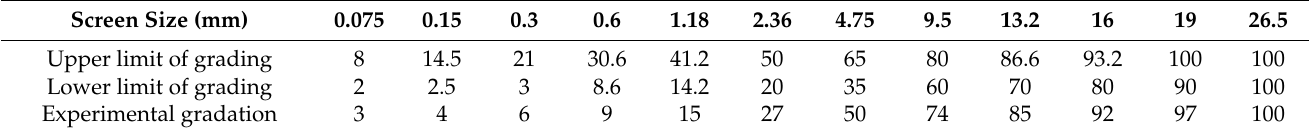
Table 6. Data of the experimental